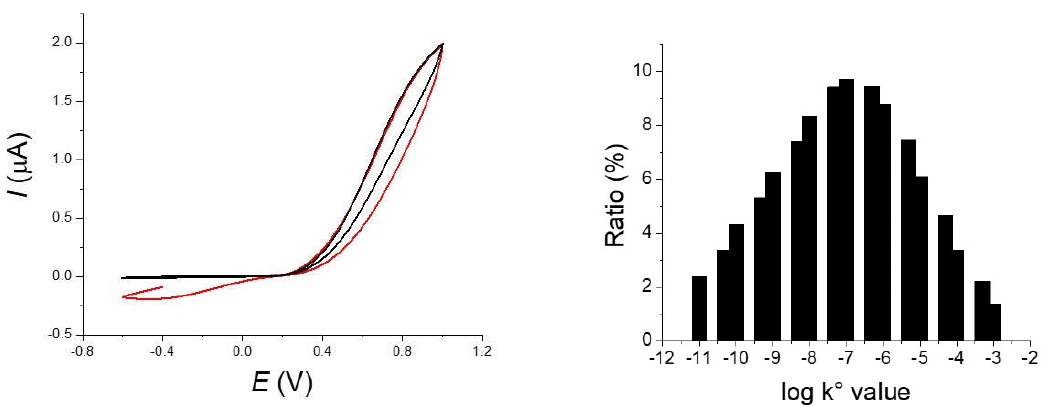
Figure 7. Simulation (red) and experimental curves (black) of a 10 −2 mol L −1 solution of potassium ferrocyanide in 0.5 mol L −1 KCl water solution at 1 V s -−1 . Parameters used for the simulation are r = 4.5 µm; l = 1.05 mm; α = 0.5; E° = 0.175 V and a distribution of values for k s showed in the histogram.